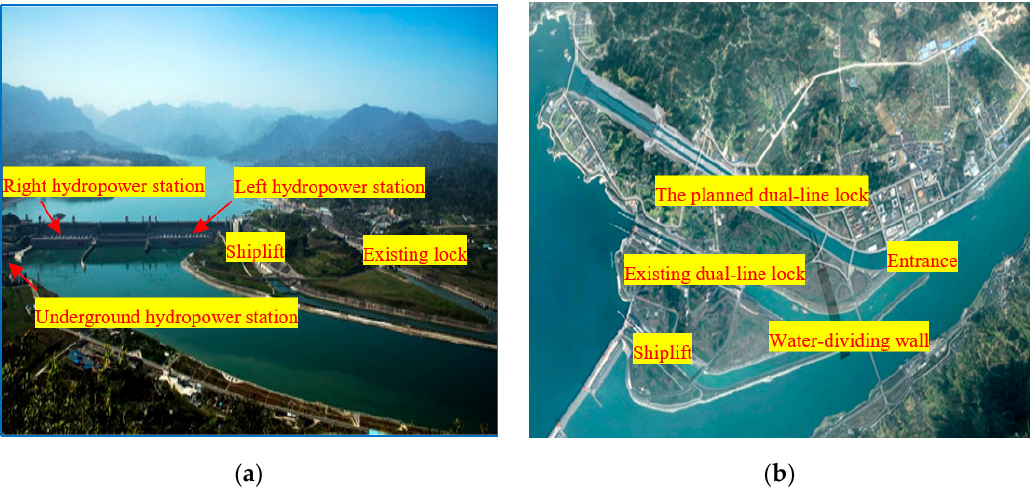
Figure 1. The layout of the Three Gorges Project (TGP). ( a ) View of the downstream of the existing TGP; ( b ) Layout of the planned lock for the